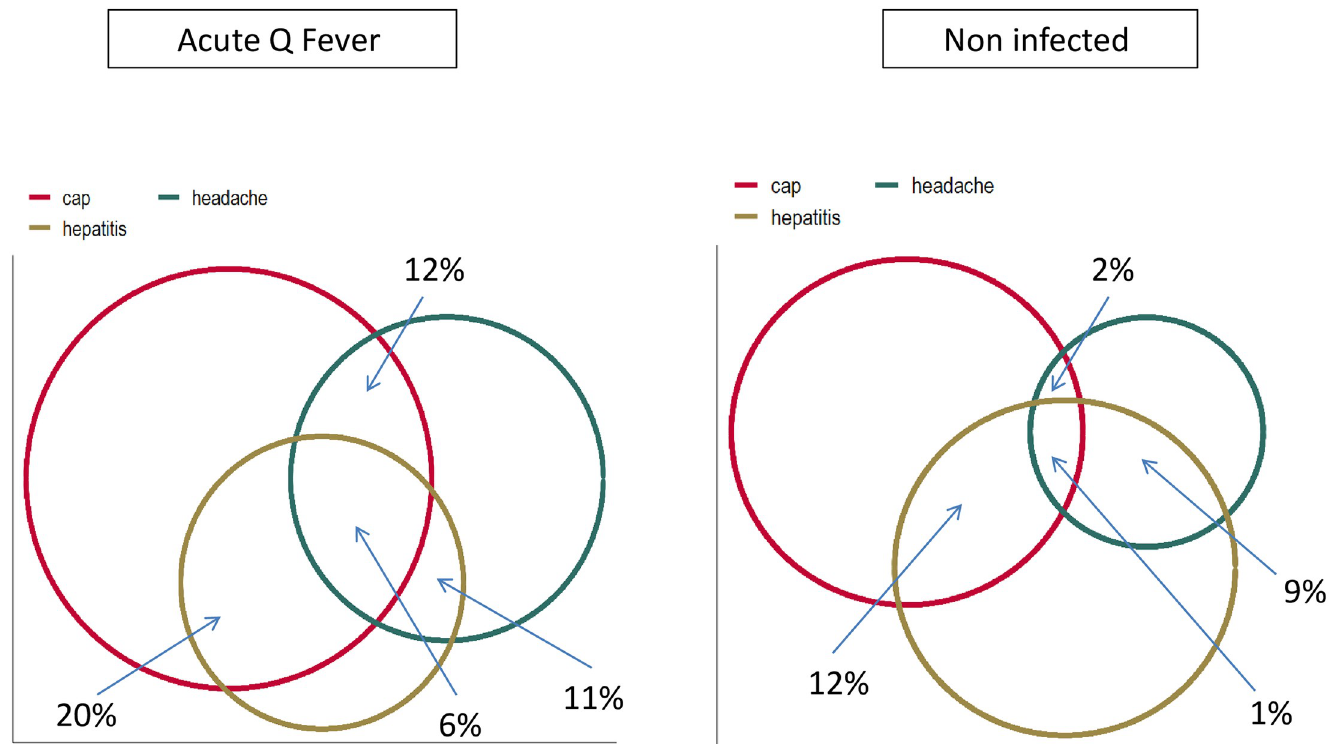
Fig 3. Venn diagram showing the percentage of patients with each “syndromic picture” in the acute Q fever and non infected group. Cap—community acquired pneumonia.